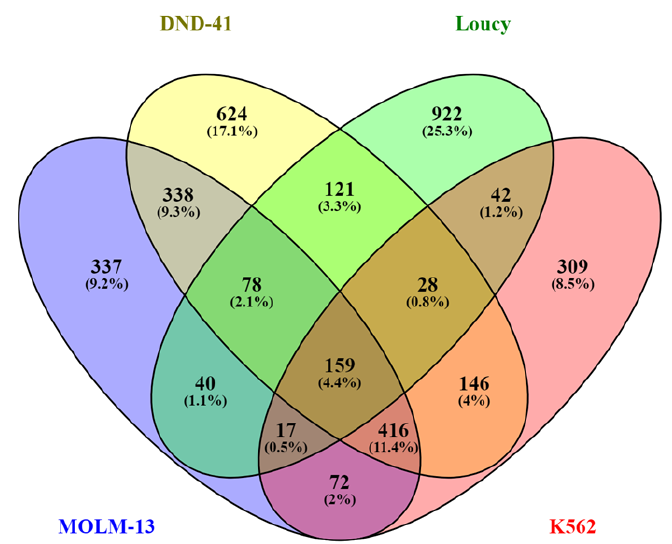
Figure 2. Distribution of genes with the broad H3K79me2 domain in MOLM-13, K562, Loucy, and DND-41 cells. The number of genes that are unique and in common in the top 5% of genes with the broad H3K79me2 among the four cell lines is shown. Table 2. GO terms (biological processes) for genes with the broadest H3K79me2 domains unique to one of the four cell lines.